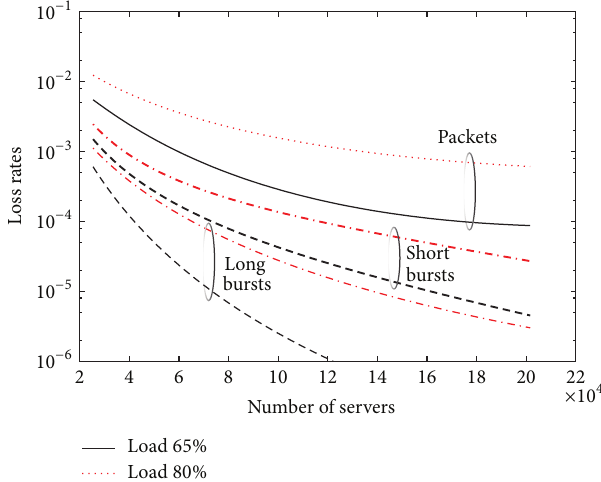
Figure 7: Average delays in the HOS network as a function of the input load and for two different input traffic distributions, namely, lognormal and